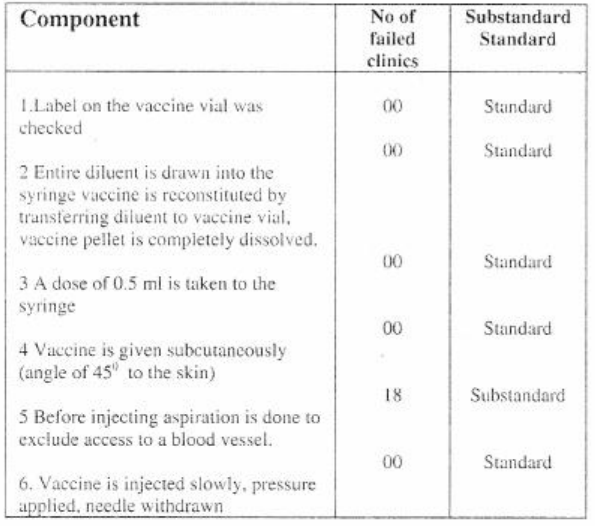
Table5. Assessmentofthe documentation